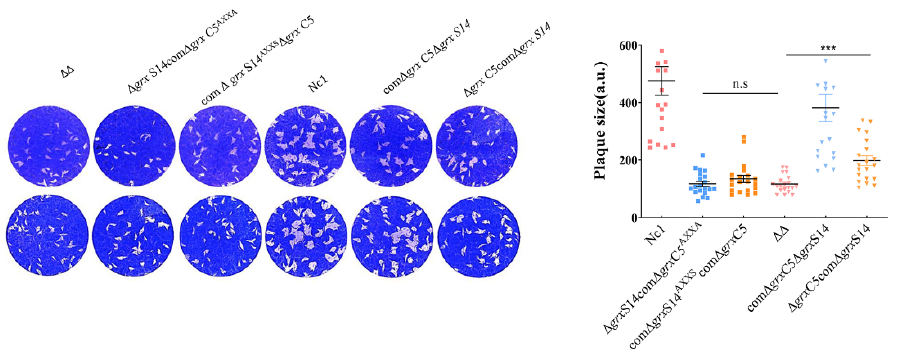
Figure 5. Phenotypes of strains with mutations of key amino acids. Plaque assay comparing growth of the com Δ grx S14 AXXS Δ grx C5, Δ grx S14 com Δ grx C5 AXXA , com Δ grx S14 Δ grx C5 , Δ grx S14 com Δ